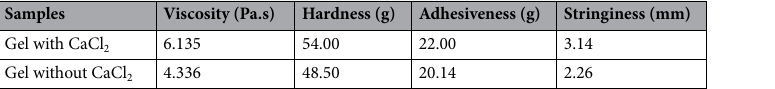
Table 3. The results of viscosity and adhesive abilities of the GenNLC-Dex-Mox hydrogel with or without CaCl 2